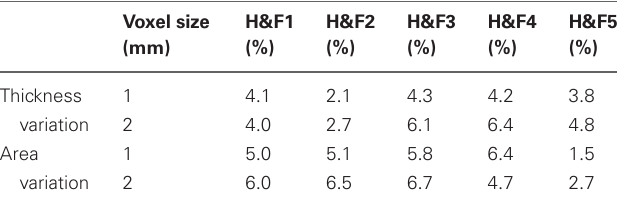
Table 2 | Mean absolute % differences in thickness and area within the five Hofer and Frahm (H&F) compartments across two imaging sessions for 20 subjects who underwent repeated scanning in the OASIS-20 database.